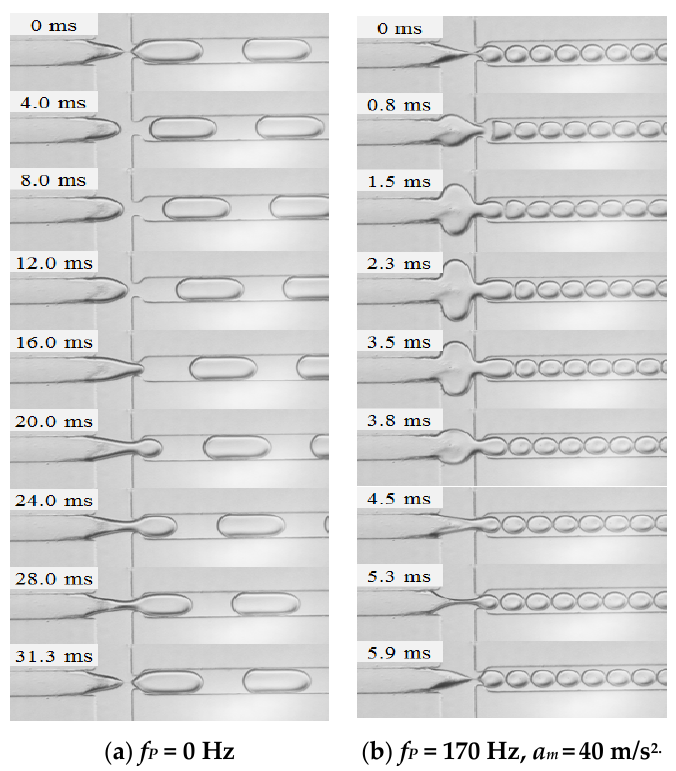
Figure 9. Evolutions of droplet generation process without/with mechanical vibration in the flow- focusing microfluidic device. ( Q c = 60 μ L/h and Q d = 60 μ L/h.). flow-focusing microfluidic device. ( Q c = 60 µ L / h and Q d = 60 µ L /